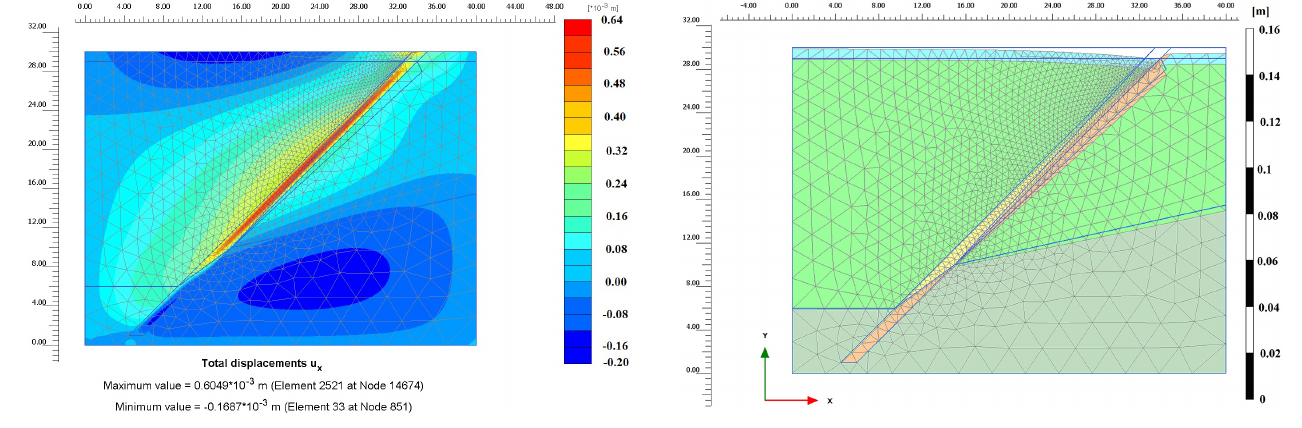
Figure 7. Deformed mesh after fast water